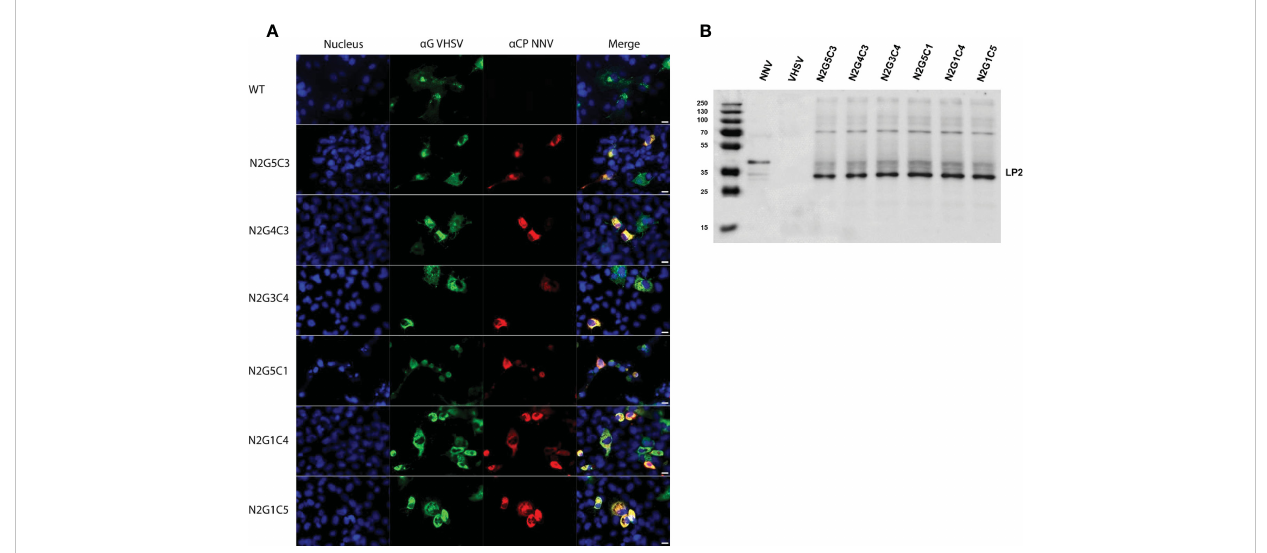
FIGURE 6 Characterization of rVHSV GO -NNV in vitro in fi sh cells and validation of NNV epitope incorporation in recombinant virus particles. (A) The expression of NNV antigens was assessed by indirect immuno fl uorescence assays on EPC cells. The cells were infected with rVHSV GO -NNV at an MOI of 0.1 and incubated at 14 ˚ C. At 72 h post-infection, cells were fi xed and permeabilized with alcohol/acetone and NNV and VHSV G expression were detected using a pAb against NNV (red) and a mAb against VHSV G (green), respectively. Nuclei were stained with Hoechst (blue). Bars, 10 µm. (B) Two micrograms of sucrose-puri fi ed viruses were denatured, loaded and migrated on an SDS page gel. NNV LP2 antigen was detected with a rabbit pAb directed against NNV.